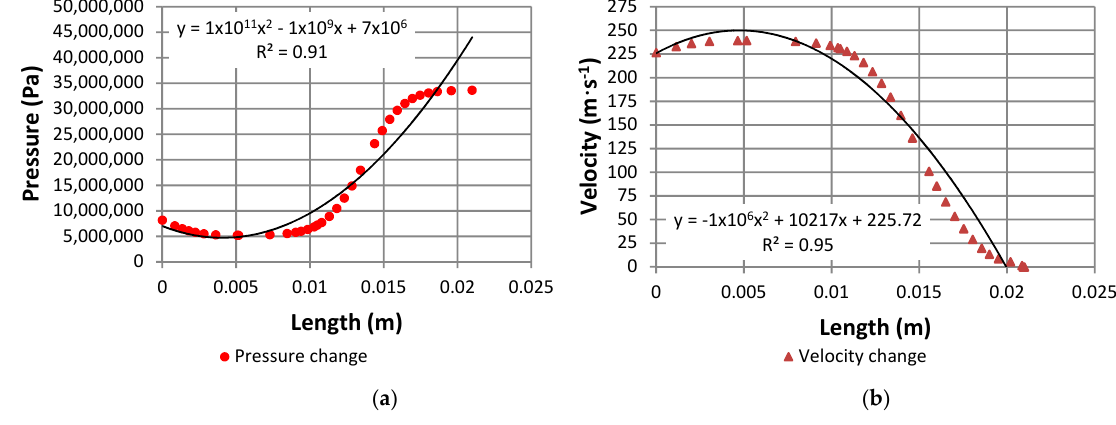
Figure 13. The variation curves of pressure ( p ) ( a ) and velocity ( υ ) ( b ) for volume flow rate 0.01m 3 · s − 1 (600 L · min − 1 ).